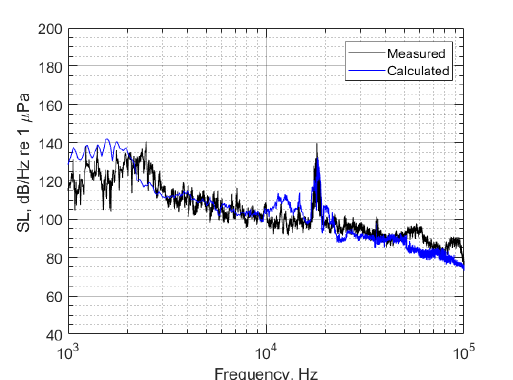
Figure 13. Comparison between measured and calculated source levels for condition C 1. Comparisons were also made for the other conditions. This is illustrated in Figure 14. The same conclusion can be drawn, with few differences in the